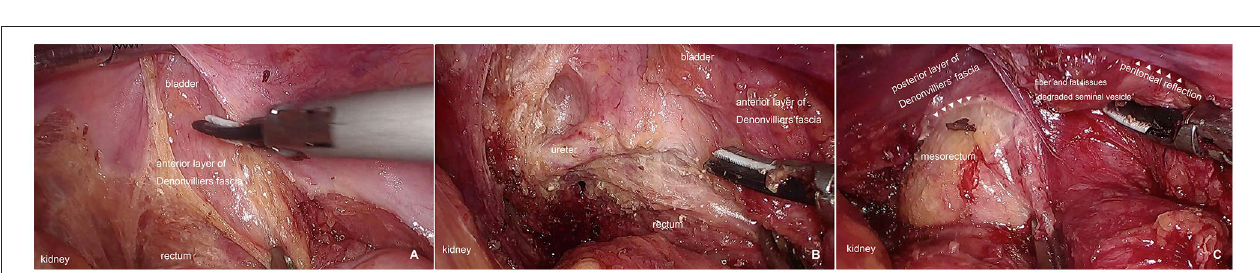
FIGURE 3 | (A–C) Intraoperative images of pelvic dissection under